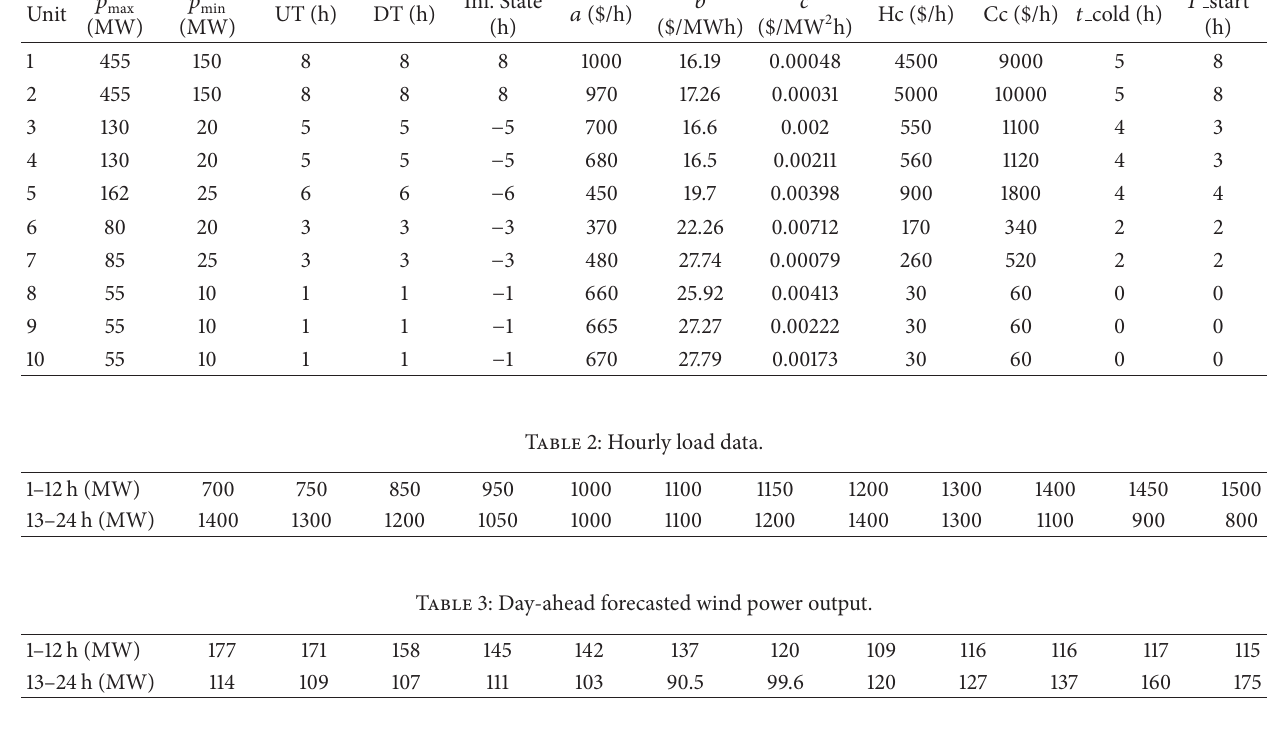
Table 4: UC decision using traditional two-stage stochastic model.